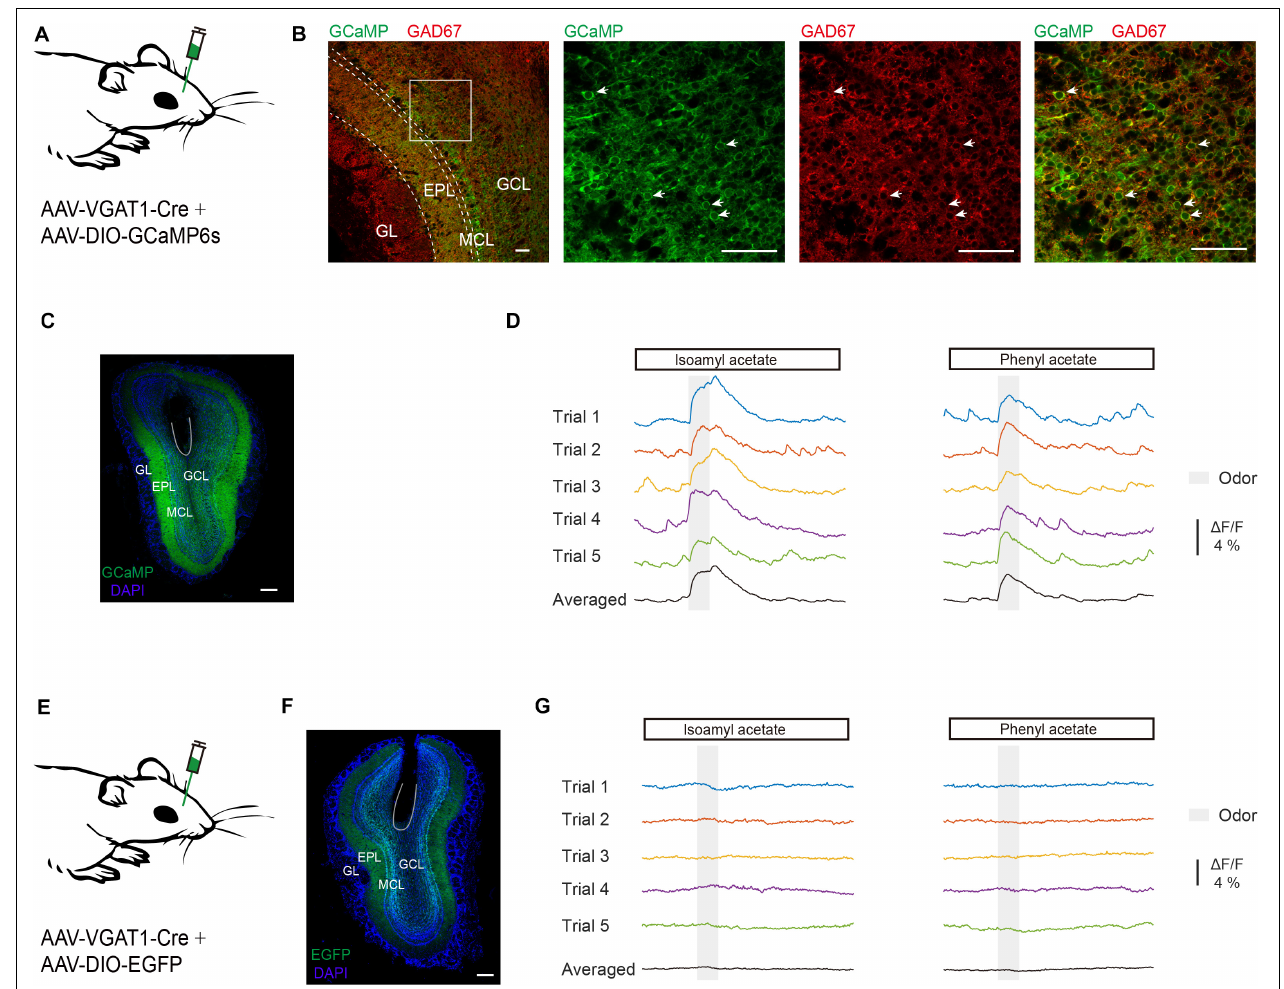
FIGURE 1 | Odor-evoked responses are recorded in GCs of the OB. (A) Diagram of virus injection. To record the odor-evoked calcium responses of granule cells, AAV-VGAT1-Cre and AAV-DIO-GCaMP6s were injected into the OB of C57BL/6J mice. (B) Expression pattern in the OB following virus injection. Note the dense labeling in the granule cell layer and the external plexiform layer. Expression of GCaMP6s in the granule cell layer co-localizes with immunolabeling of GAD67. GL, Glomerular layer; EPL, external plexiform layer; MCL, mitral cell layer; GCL, granule cell layer. Scale bar = 50 µ m. (C) Representative viral transduction (GCaMP6s) and fiber location. Expression of GCaMP6s in the OB. Within the OB, GCaMP6s is expressed in the granule cells. Scale bar = 200 µ m. (D) Typical traces and trial-averaged traces of the calcium responses evoked by isoamyl acetate and phenyl acetate. (E) Diagram of virus injection. AAV-VGAT1-Cre and AAV-DIO-EGFP were injected into the OB of C57BL/6J mice. (F) Representative viral transduction (EGFP) and fiber location. Scale bar = 200 mm. (G) Odors evoked no response in a control